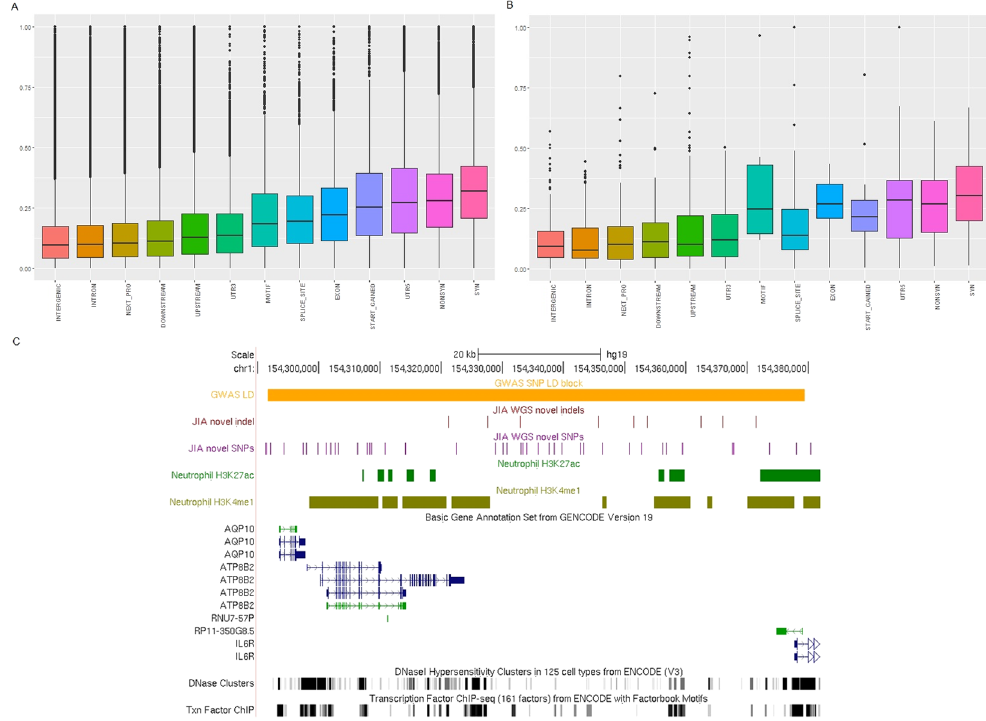
Figure 3. JIA SNPs within linkage disequibilium (LD) blocks containing previously identified JIA-associated SNPs. Boxplot shows regulatory potential scores for SNPs overlapping blocks of JIA-associated SNPs grouped by genomic features for ( A ) all SNPs from WGS on 48 JIA individuals and ( B ) SNPs from WGS on 48 JIA individuals overlapping LD blocks containing previously identified JIA-associated SNPs. ( C ) Genome browser screenshot shows the LD block containing the SNP, rs11265608, intersecting novel JIA SNPs and novel JIA indels. Also, overlapping with neutrophil histone mark H3K27ac and H3K4me1. The gene annotation set from GENCODE v19 is shown by the rows below the H3K4me1 mark. The two rows of black vertical line at the bottom depict DNase hypersensitivity clusters in 125 cell types from ENCODE v3 and the transcription factor ChIP sequencing of 161 factors from ENCODE with factorbook